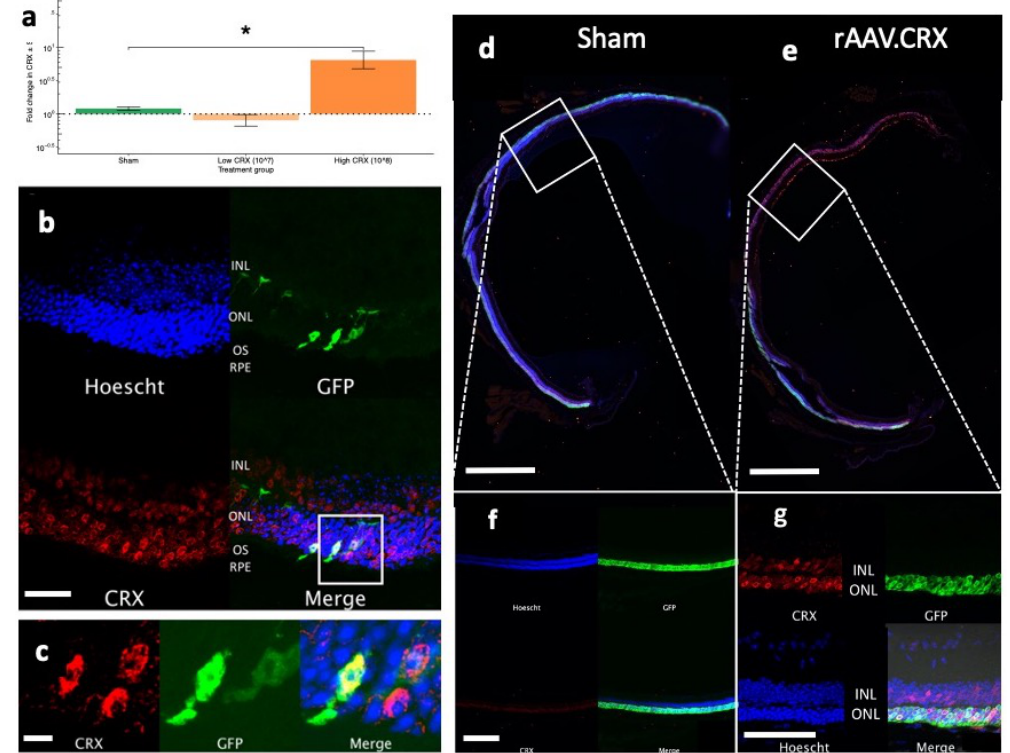
Figure 5. CRX transgene overexpression by subretinal rAAV injections. ( a ) Fold-change in CRX gene expression in Rho −/− OPN1-GFP mouse retinas injected with high dose rAAV.CRX (1.5 × 10 8 gc; dark orange; n = 4), low dose rAAV.CRX (1.5 × 10 7 gc; light orange; n = 4) or sham PBS (green; n = 4). A significant increase occurred in only the 1.5 × 10 8 gc treated retinas. * denotes p < 0.05 compared to sham eyes. All values mean ± SEM. ( b ) Superior retina of an rAAV.CRX (1.5 × 10 8 gc) treated eye in an Rho −/− , OPN1-GFP mouse sacrificed at PNW 10 (7 weeks following surgery). Nuclear-specific Crx staining is seen throughout the outer nuclear layer and, more lightly, in the inner nuclear layer. Scale bar = 25µm ( c ) Enlarged area of interest showing colocalization of CRX with endogenous GFP in cone photoreceptors, confined to the nuclei and not extending into the outer segment. CRX staining also occurs in other non-GFP labelled nuclei which are likely rod cells. Scale bar = 5µm ( e , g ) rAAV.CRX (1.5 × 10 8 gc) injected pilot study Rho −/− Nrl-GFP retinas showing CRX staining in the ONL and INL. rAAV.CRX injected superior retinas showed a far stronger CRX staining pattern compared to the inferior retinas of the injected eyes, as well as contralateral sham injected eyes ( d , f ). Scale bars d,e both = 1mm. Scale bars f,g both = 50 µ